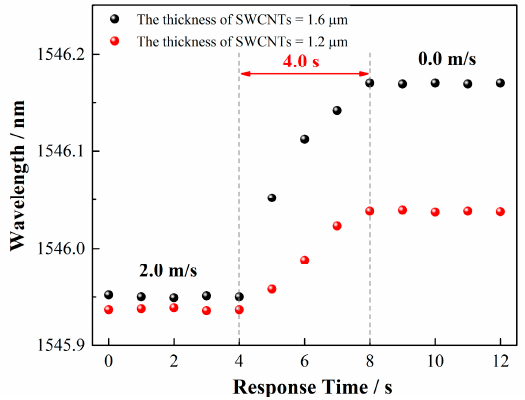
Figure 9. Sensitivity as a function of wind speed under different input powers.